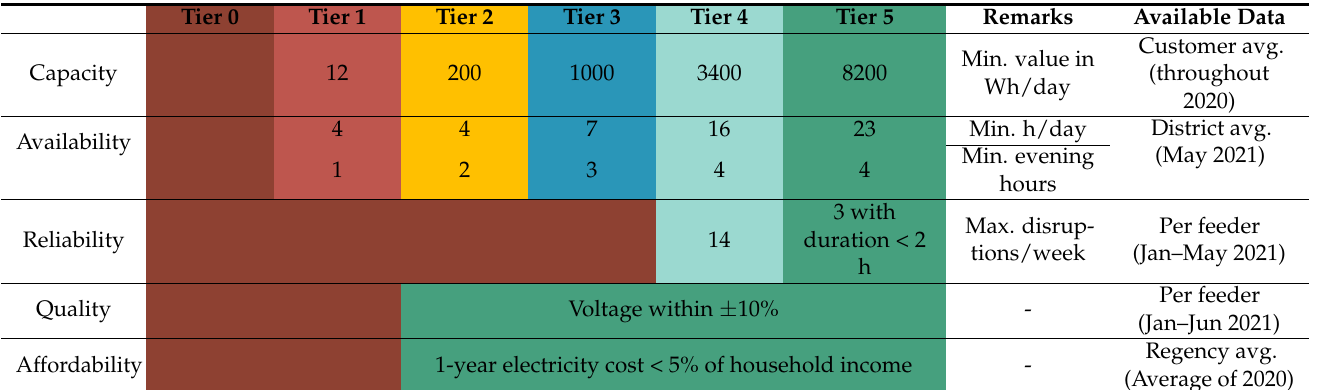
Table 1. MTF matrix to assess energy access (adapted from